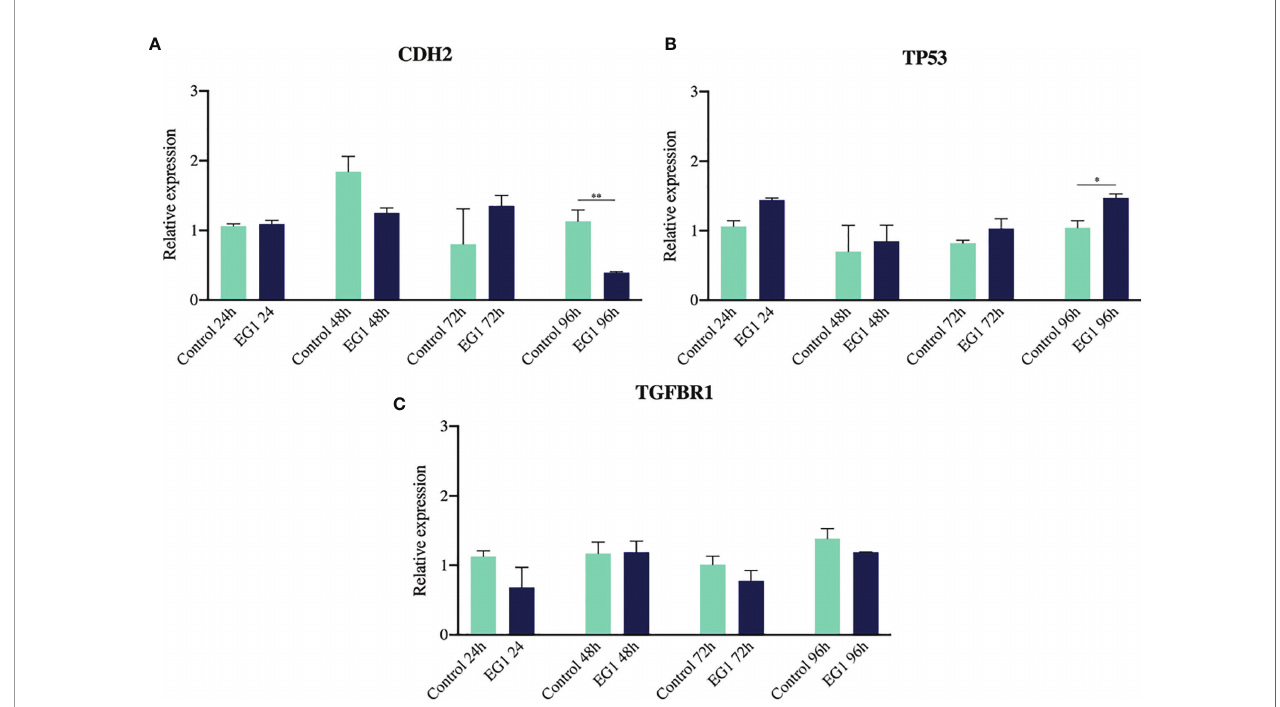
FIGURE 9 | Gene expression of CDH2 , TP53 and TGFBR1 via RT-qPCR. (A) N-cadherin showed a reduction in gene expression on days three and four of treatment, consistent with previous evidence that PAX2 siRNA-mediated knockdown inhibits N-cadherin ( CDH2 ) expression (n=3). (B) The tumour suppressor TP53 had increased expression after four days of EG1 treatment, which is hypothesized to be due to TP53 being normally transcriptionally repressed by PAX2, PAX5 and PAX8 regulation (n=3). (C) There was no change in TGFBR1 expression between the control and EG1 treated populations over 96 hours (n=3). (*p < 0.05, **p <